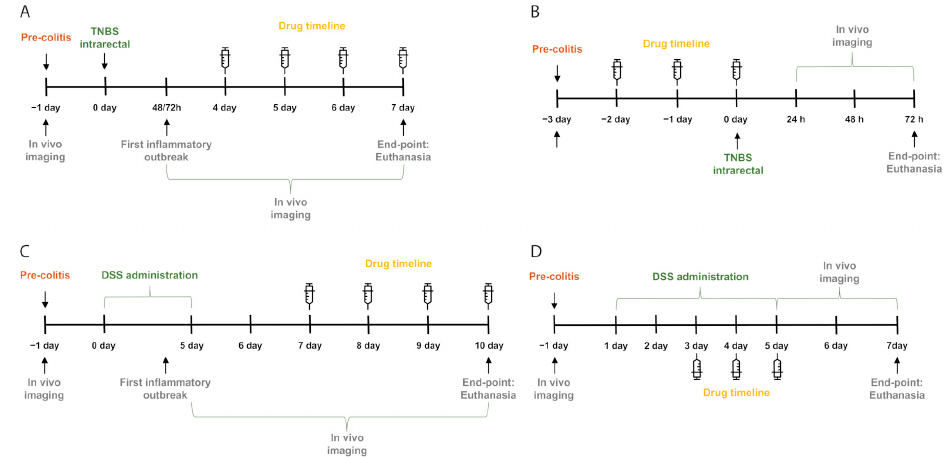
Figure 7. Graphical representation of the experimental design of the four chemically induced colitis approaches. Experimental design throughout time for the preventive ( A ) and therapeutic ( B ) approaches for TNBS and the preventive ( C ) and therapeutic ( D ) trials in DSS mice. Time is represented as days. Negative days are prior to colitis inducer administration. Colitis inducer administration and in vivo imaging are indicated as arrows or brackets. Drug delivery is marked as syringes. End ‐ point refers to the last day of the trial.